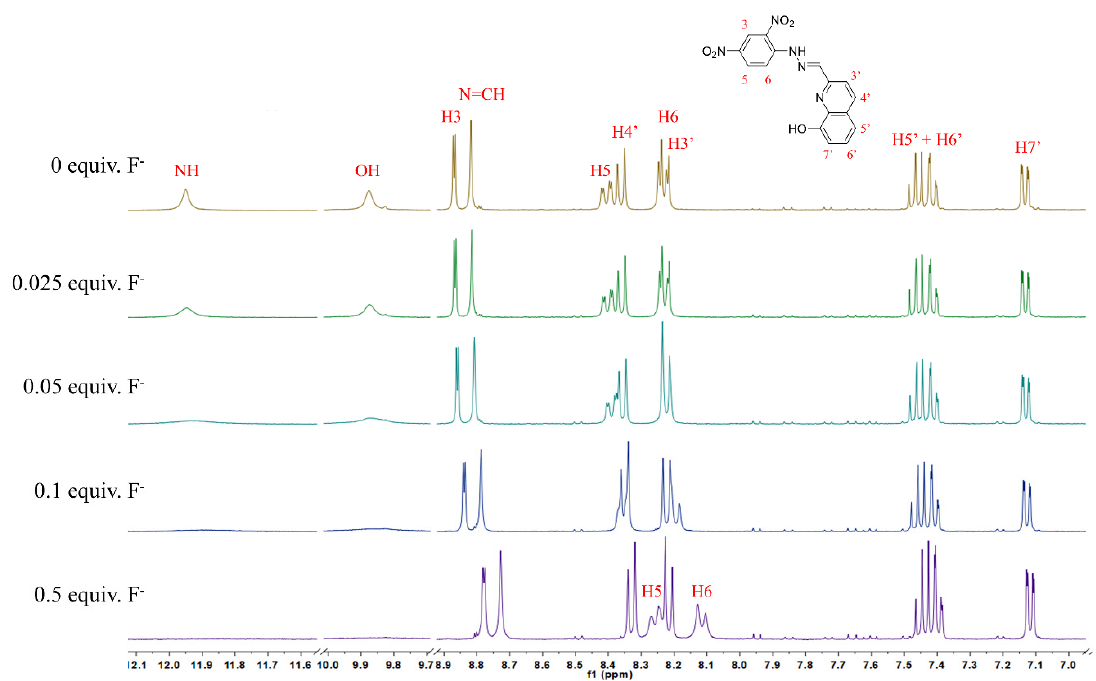
Figure 8. NMR titration of compound 3b with F − in DMSO- d6 .